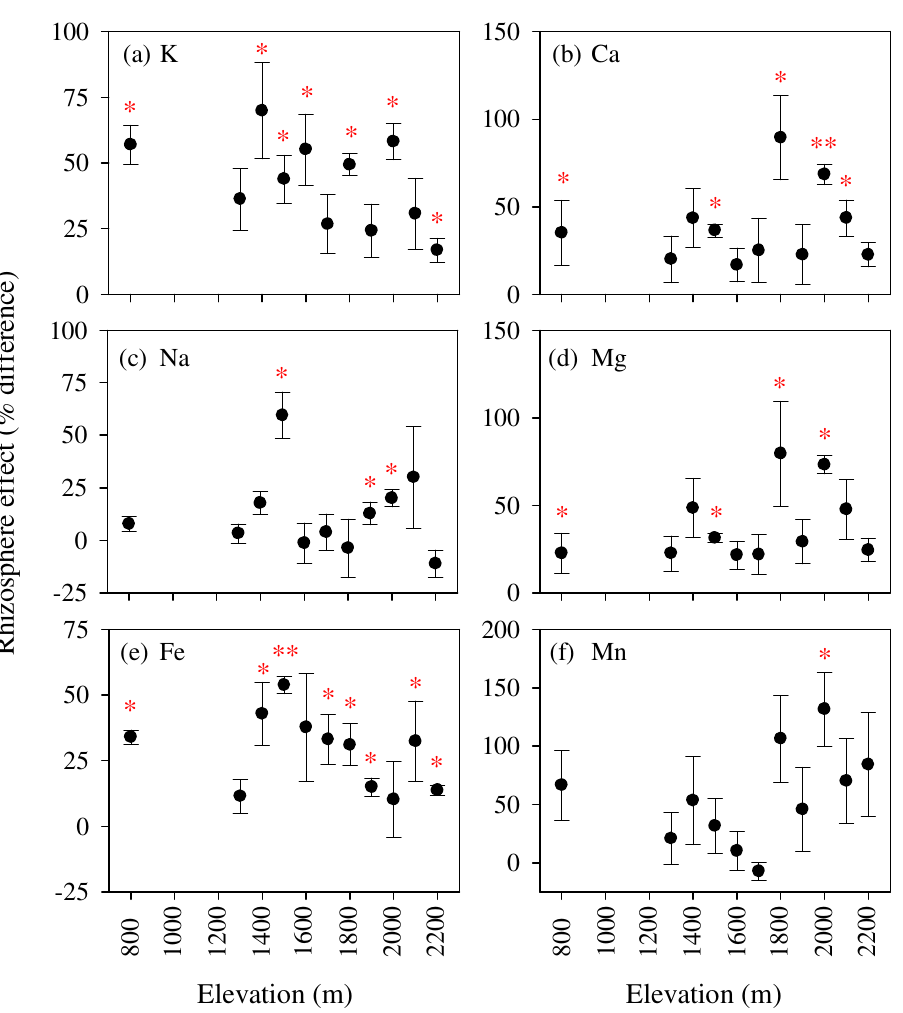
Figure 5. Relationship of the rhizosphere effects on soil extractable potassium kalium (K, ( a )), ex- tractable calcium (Ca, ( b )), extractable natrium (Na, ( c )), extractable magnesium (Mg, ( d )), extractable ferrum (Fe, ( e )) and manganese (Mn, ( f )) with elevation. There was no significant linear regression ( p > 0.05). For each elevation, values are the means and error bars are the standard errors of replicated plots ( n = 4). Asterisks indicate significant differences between rhizosphere soil and bulk soil based on paired−samples t −tests (* p < 0.05 and ** p < 0.01).